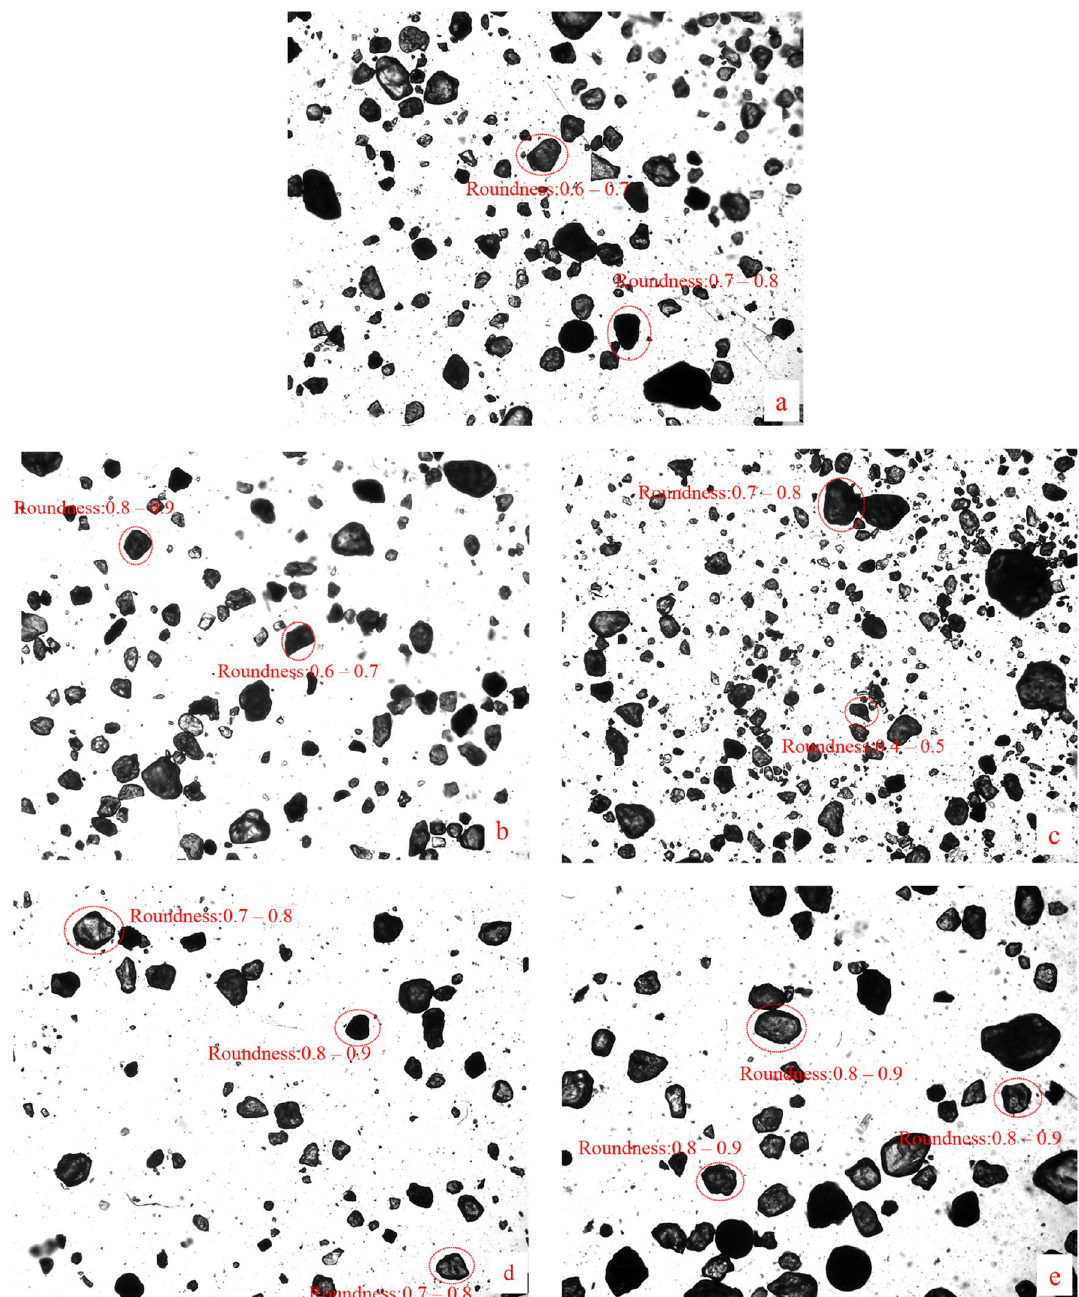
Figure 9. Specimen (FS) particle images after the freeze–thaw cycles ( a 0 freeze–thaw cycles; b 5 freeze–thaw cycles; c 10 freeze–thaw cycles; d 50 freeze–thaw cycles; e 100 freeze–thaw